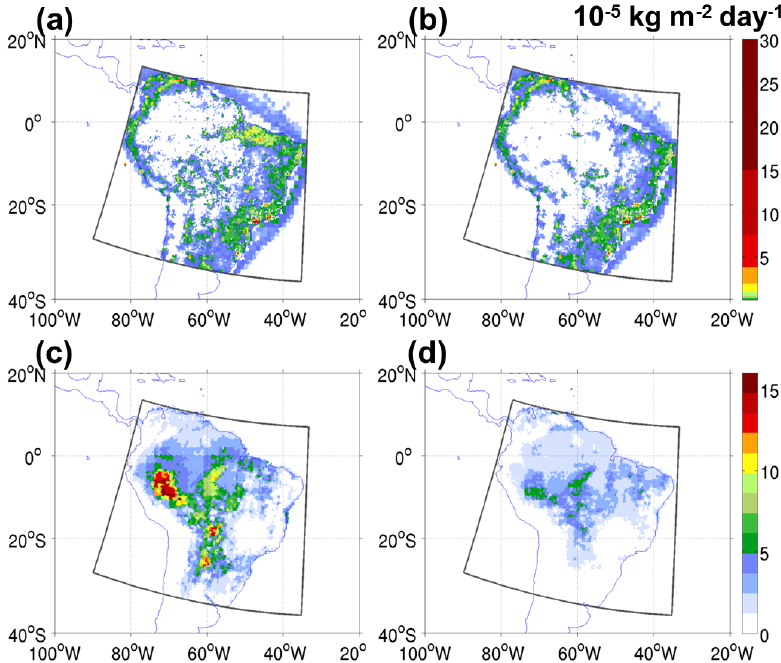
Figure 17. Mean emission rates (10 − 5 kgm − 2 d − 1 ) from PREP-CHEM-SRC for the 35km domain (dark gray outline) for NO x for